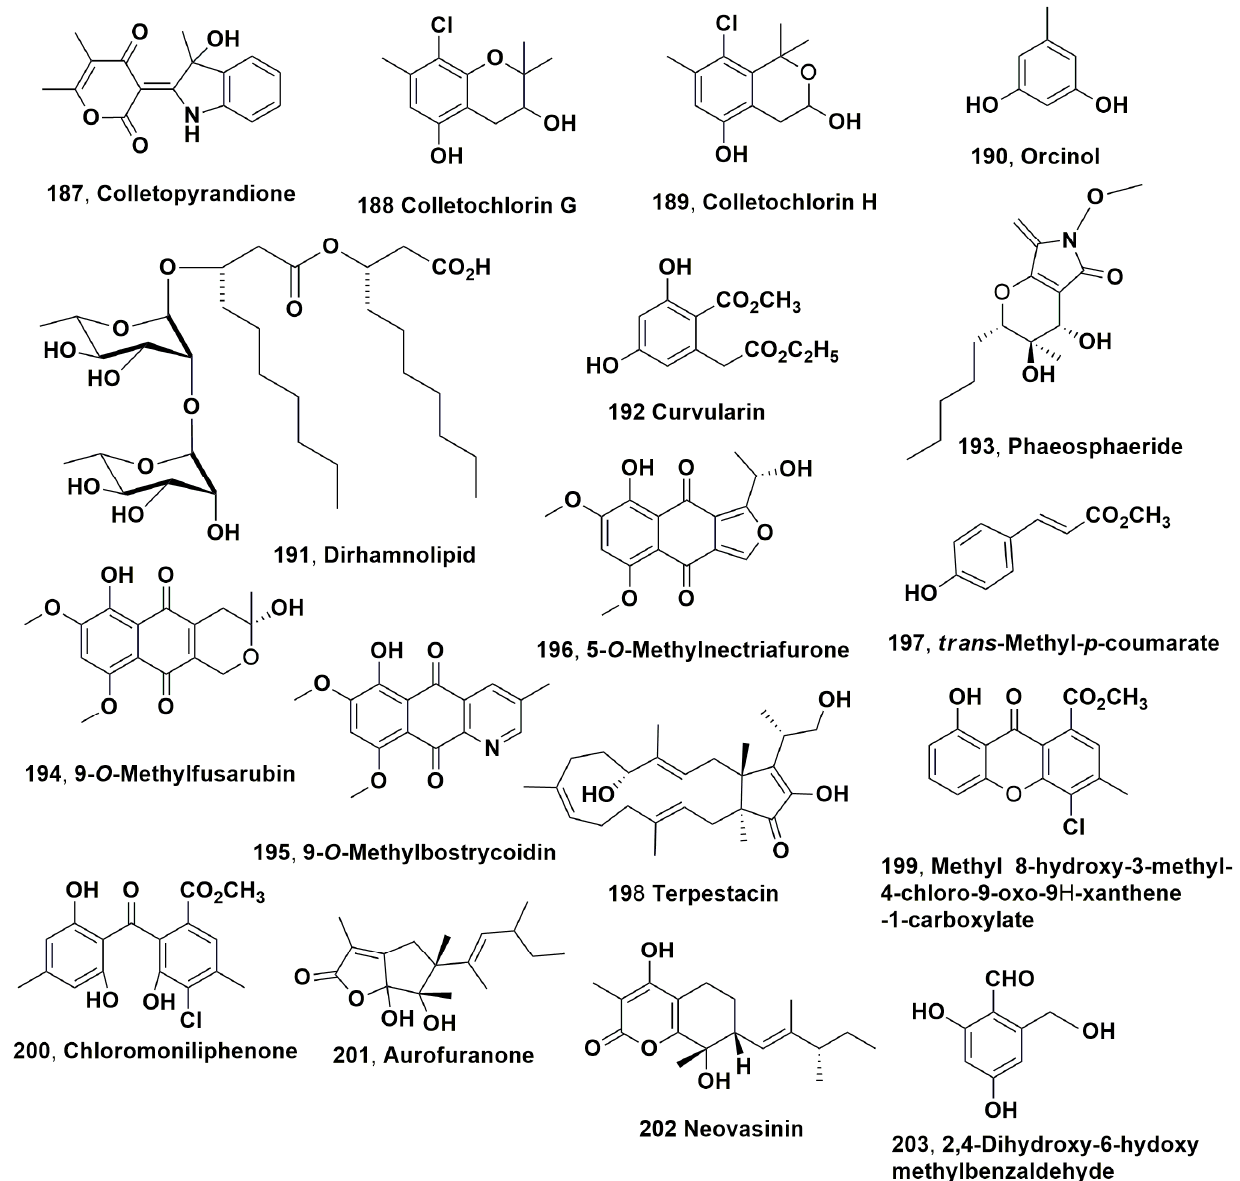
Figure 8. Metabolites produced by Colletotrichum higginsianum ( 187 – 190 ), Colletotrichum gloeosporioides ( 191 ), Paraphoma sp. ( 192 and 193 ), Rutstroemia capillus-albis ( 194 – 198 ), Alternaria sonchi ( 199 and 200 ) and Ascochyta araujiae ( 201 – 203 ).